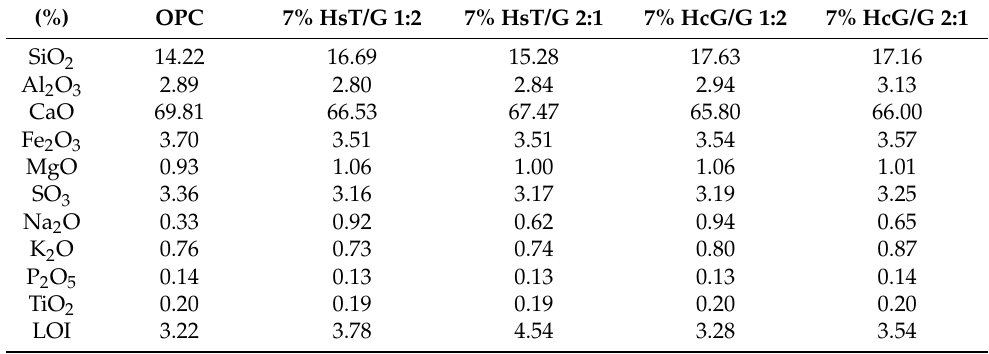
Table 2. FRX-determined chemical composition (%) of the cements studied (LOI = loss on ignition).